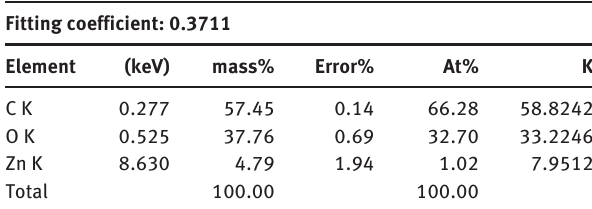
Table 4: Percentage distribution of ZnO and MWCNTs nanoparticles in the PVA composites